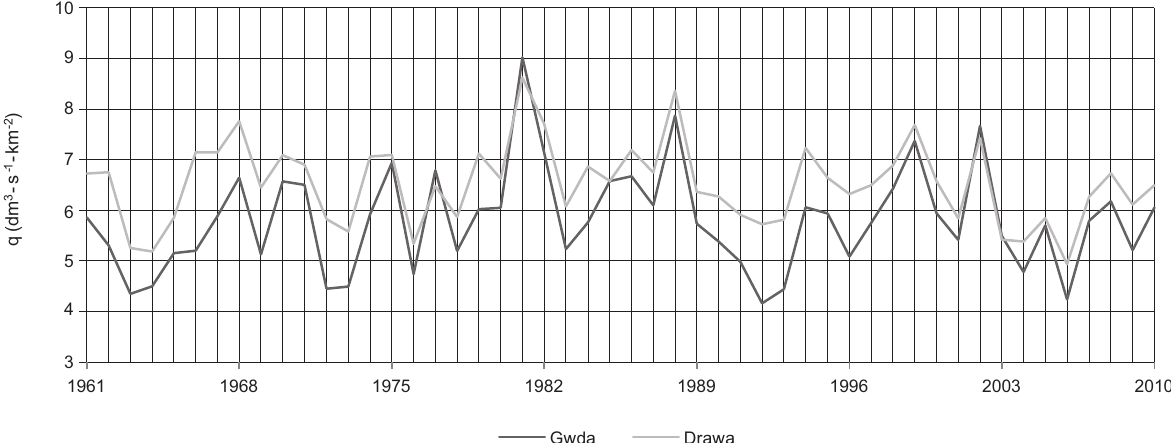
Fig. 6. Mean annual specific runoff of the Gwda River in Piła and the Drawa River in Drawiny in hydrological years